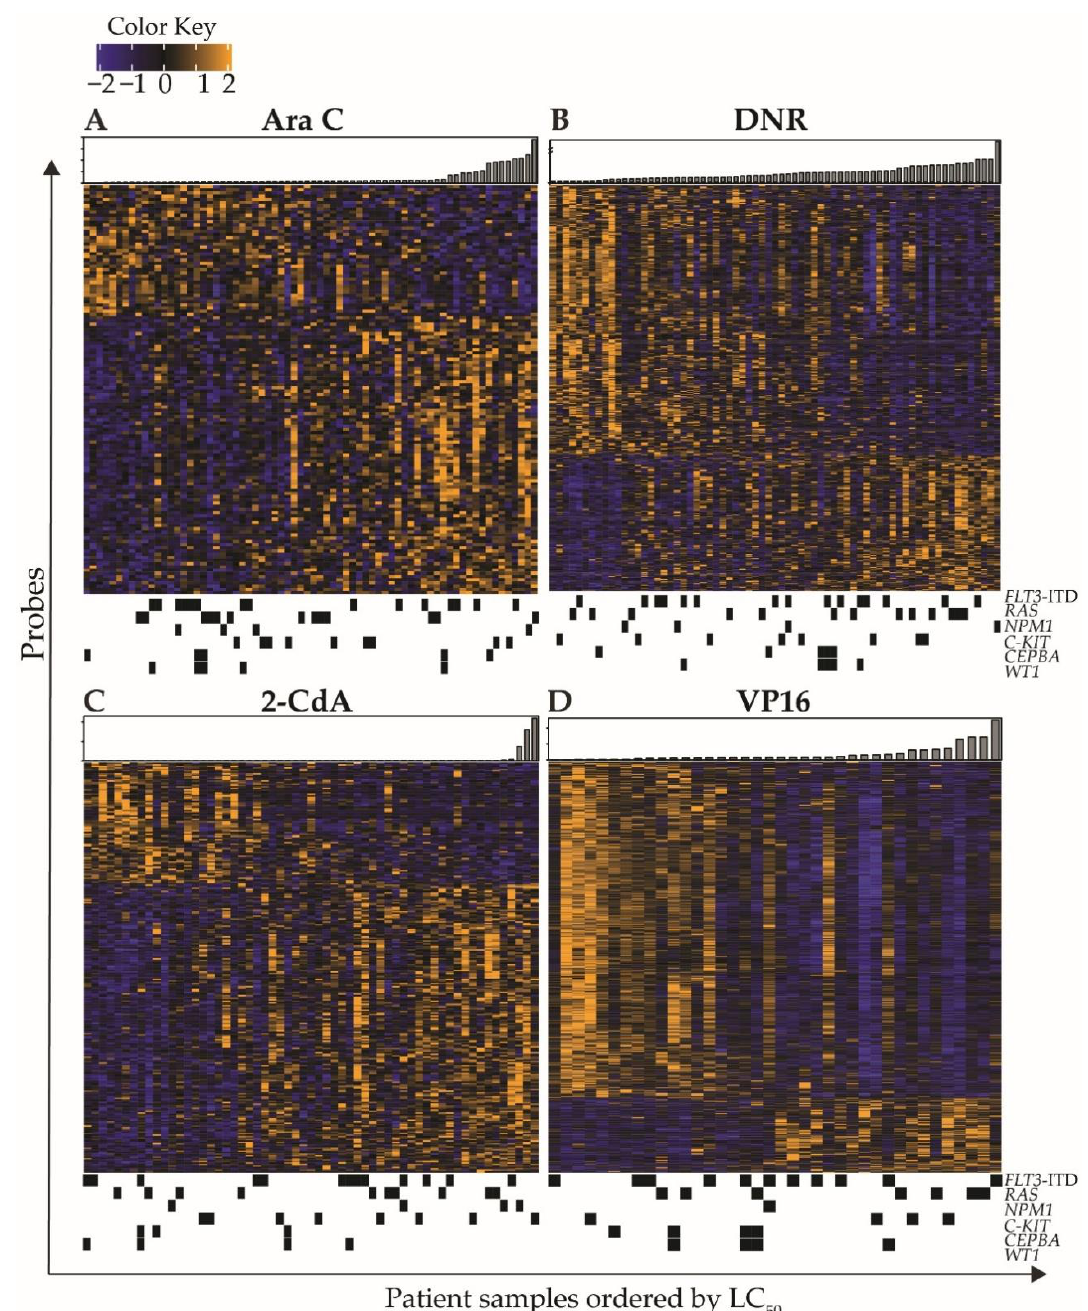
Figure 3. Heatmaps of ex vivo drug response associated gene expression patterns of pediatric AML blasts. Expression of probes was correlated to ex vivo drug response LC 50 values using the Spearman’s Rank method. Probes were selected based on a p -value < 0.001. Probes (rows) were clustered using mean linkage, and samples were ordered according to ex vivo drug LC 50 towards ( A ) Ara C, ( B ) DNR, ( C ) 2-CdA, and ( D ) VP16 LC 50 . Bar plots represent LC 50 ( µ M) per patient. Black blocks underneath heatmaps indicate presence of recurrent mutations in samples.